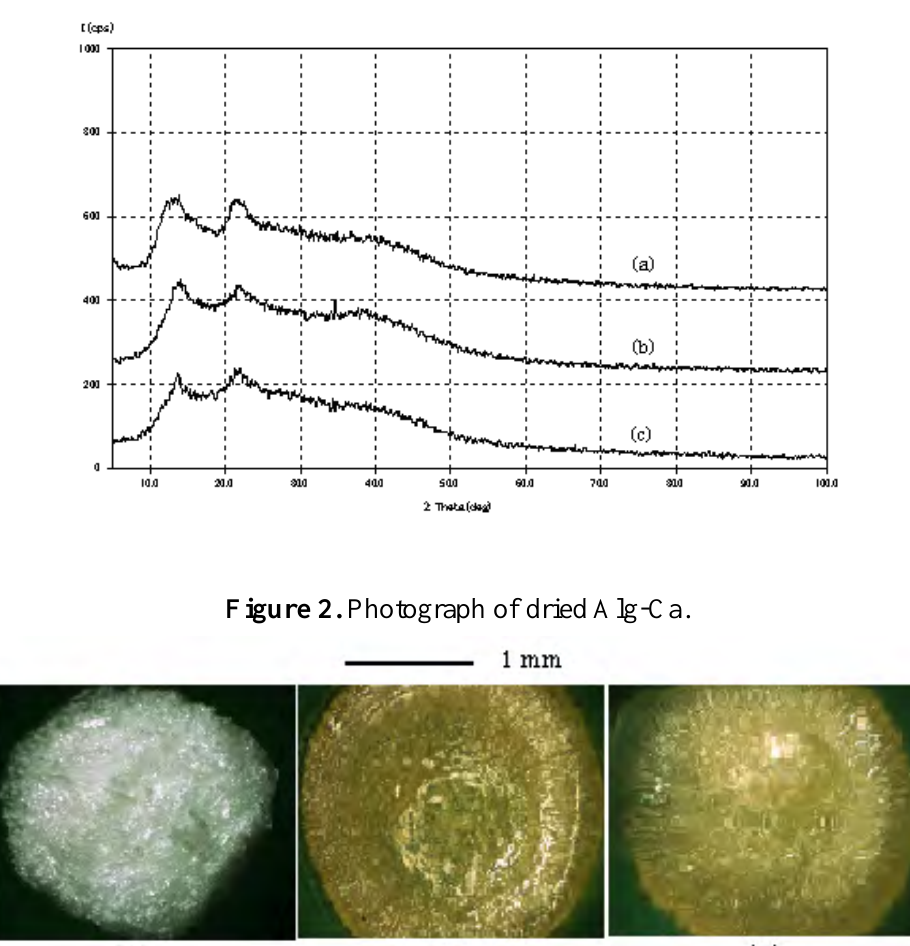
Figure 1. X-ray diffractograms of (a) Alg, (b) GB and (c) MB.